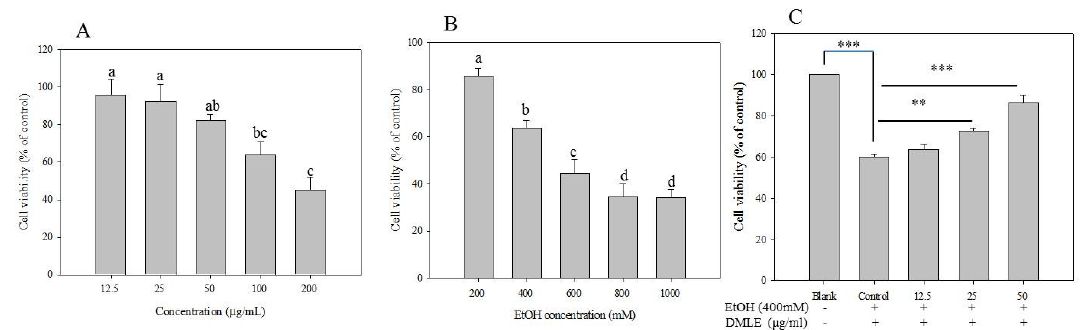
Figure 4. Cell viability ( A ), ethanol toxicity ( B ), and cytoprotective effect ( C ) of Denropanax morbifera leaf extracts. HepG2 cells exposed to deferent concentration DMLE and EtOH for 24 h. Cell viability measured by MTT assay. Data were reported as the percentage change in comparison to a blank group, which were assigned 100% viability. Data represent the mean ± S.E.M of three replicates. Different letters (a–d) indicated significant difference at p < 0.05. ** p < 0.01, *** p < 0.001.